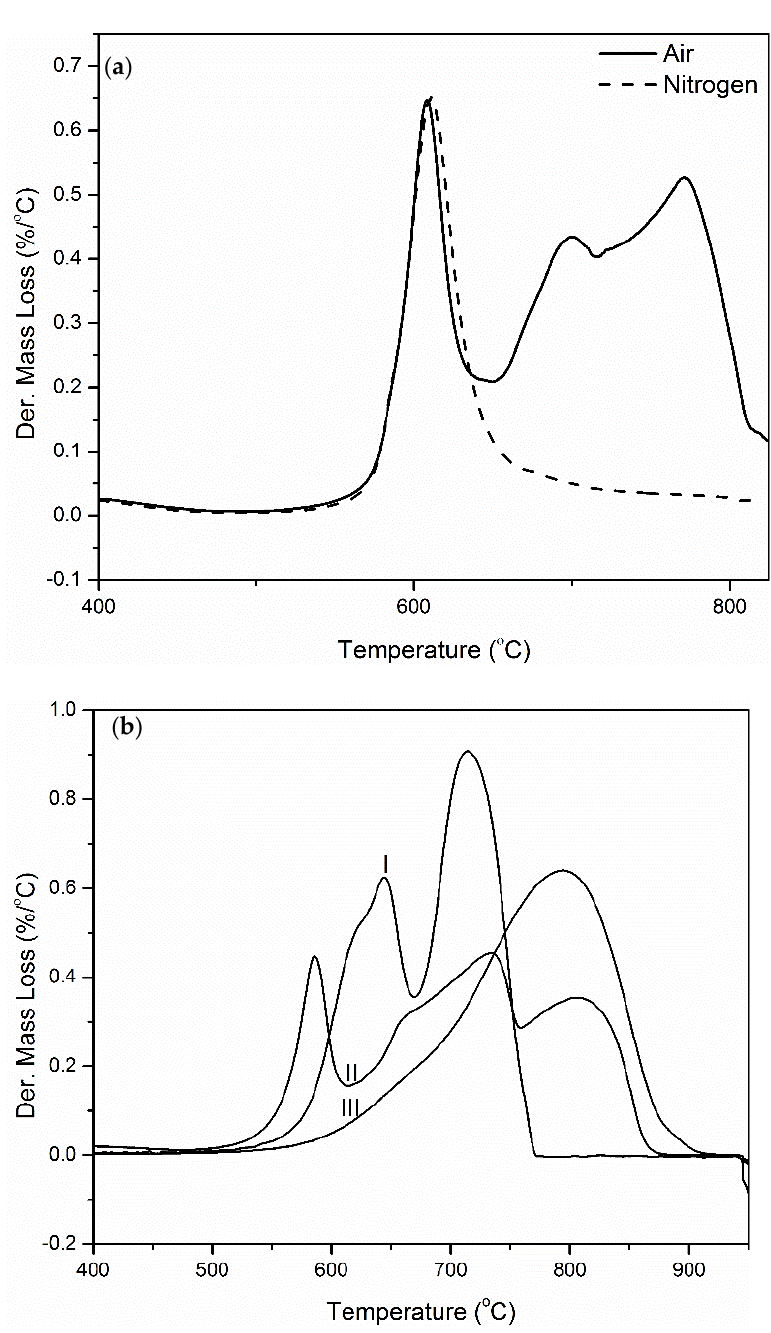
Figure 10. ( a ) TGA and derivative TGA mass loss curves in air and in nitrogen for PINGS ( b ) Derivative TGA mass loss curves (I) PI, (II) PINGS -50, and (III) Graphene (in air; β = 30 °C/min).